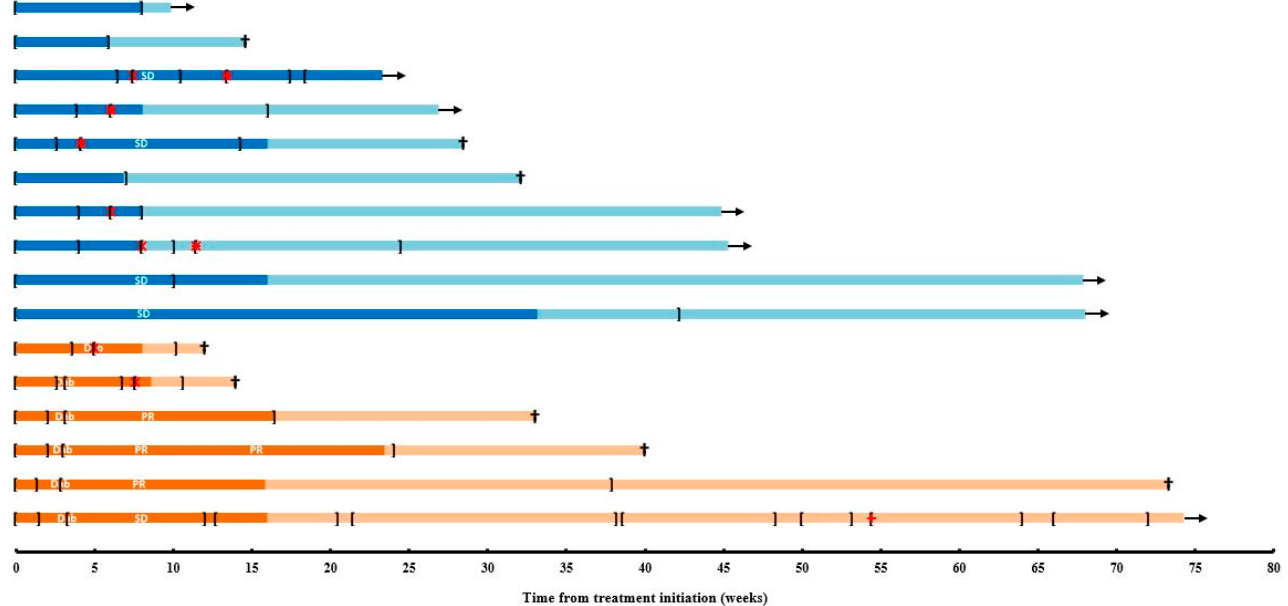
Figure 2. Swimmer plot depicting progression-free (dark orange) and overall survival (light orange) from treatment initiation in the first 6 patients enrolled prior to trial amendment and progression-free (dark blue) and overall survival (light blue) in the 10 patients enrolled after the trial amendment. Intervals on and off study therapy are depicted with square brackets ([…]). Black arrow: alive; black cross: death; Dab: addition of low-dose dabrafenib in the first six patients; PR: partial response; red X: dose reduction trametinib; red +: dose reduction dabrafenib; SD: stable disease.